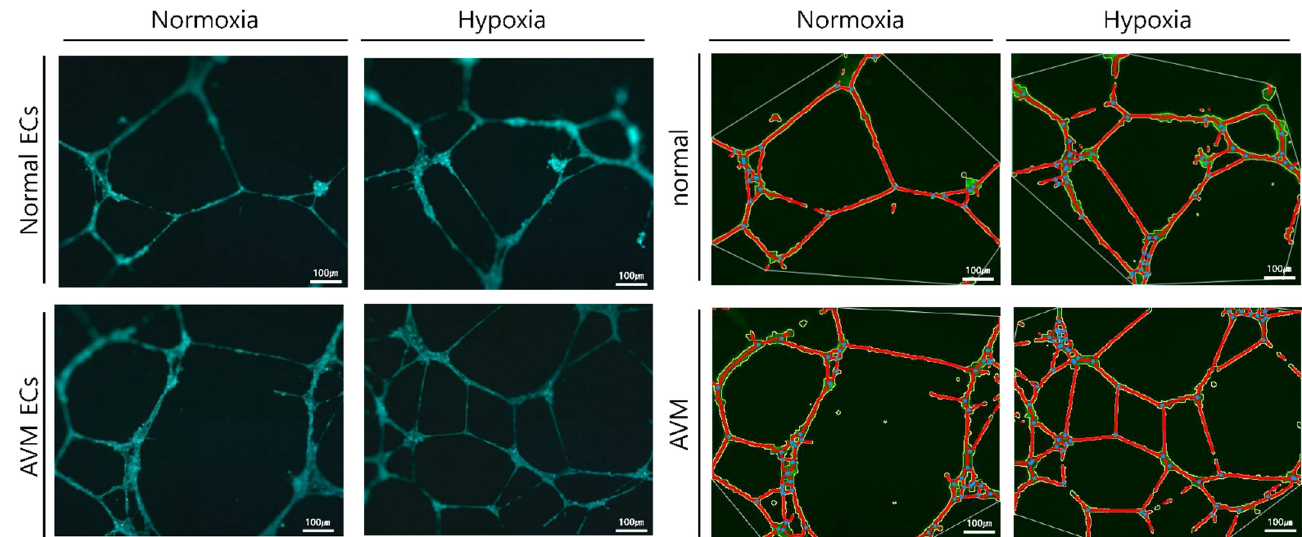
Figure 3. Angiogenesis assay of normal ECs and AVM ECs under normoxia and hypoxia. Tube formation assay for 8 h incubation. Vessels (red lines) and junctions (blue dots) are indicated. The total vessels lengths and total number of junctions were measured in the field. Compared with that of normal ECs, AVM ECs showed significantly increased numbers of tube junctions and vessel lengths. More and longer tubes were formed in the AVM ECs than normal ECs even in the hypoxia. AVM, arteriovenous malformation; EC, endothelial cell.